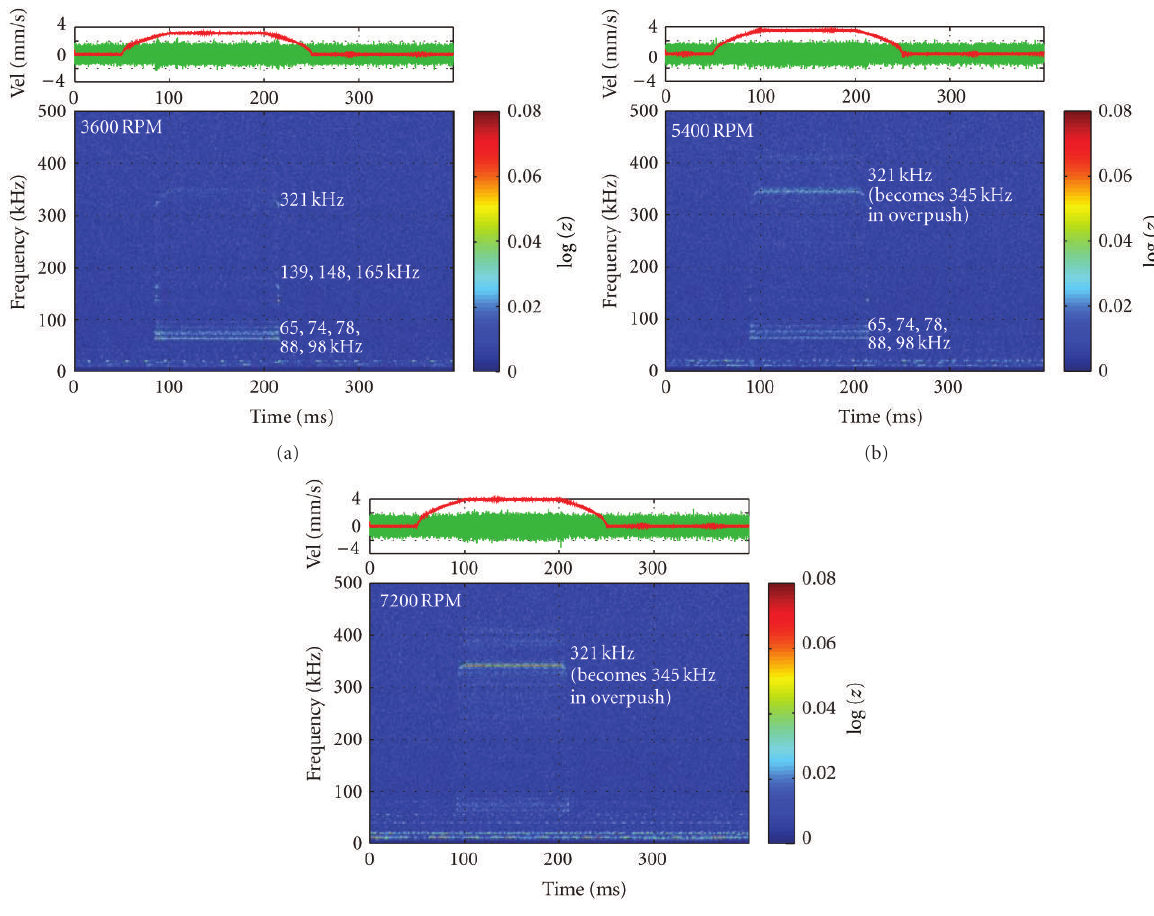
Figure 6: Applied TFC voltage profile, vertical velocity time history, and the joint time frequency spectrum of the vertical velocity for ABS-2 at di ff erent disk